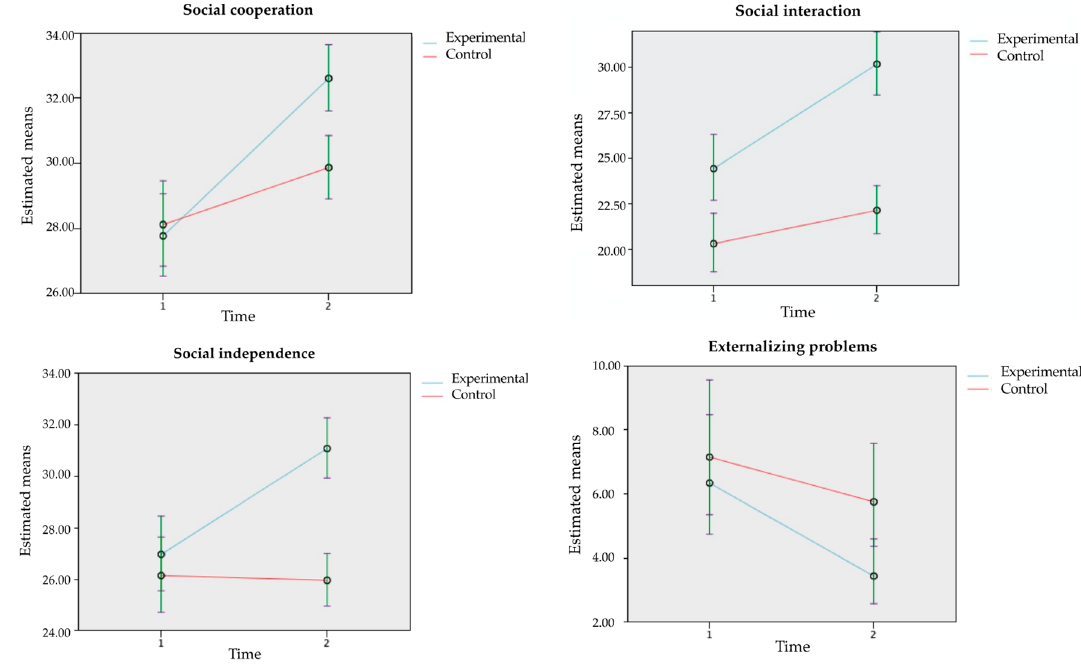
Figure 3. Pairwise contrast in the group*time interaction using the model-estimating means for the program’s variables.